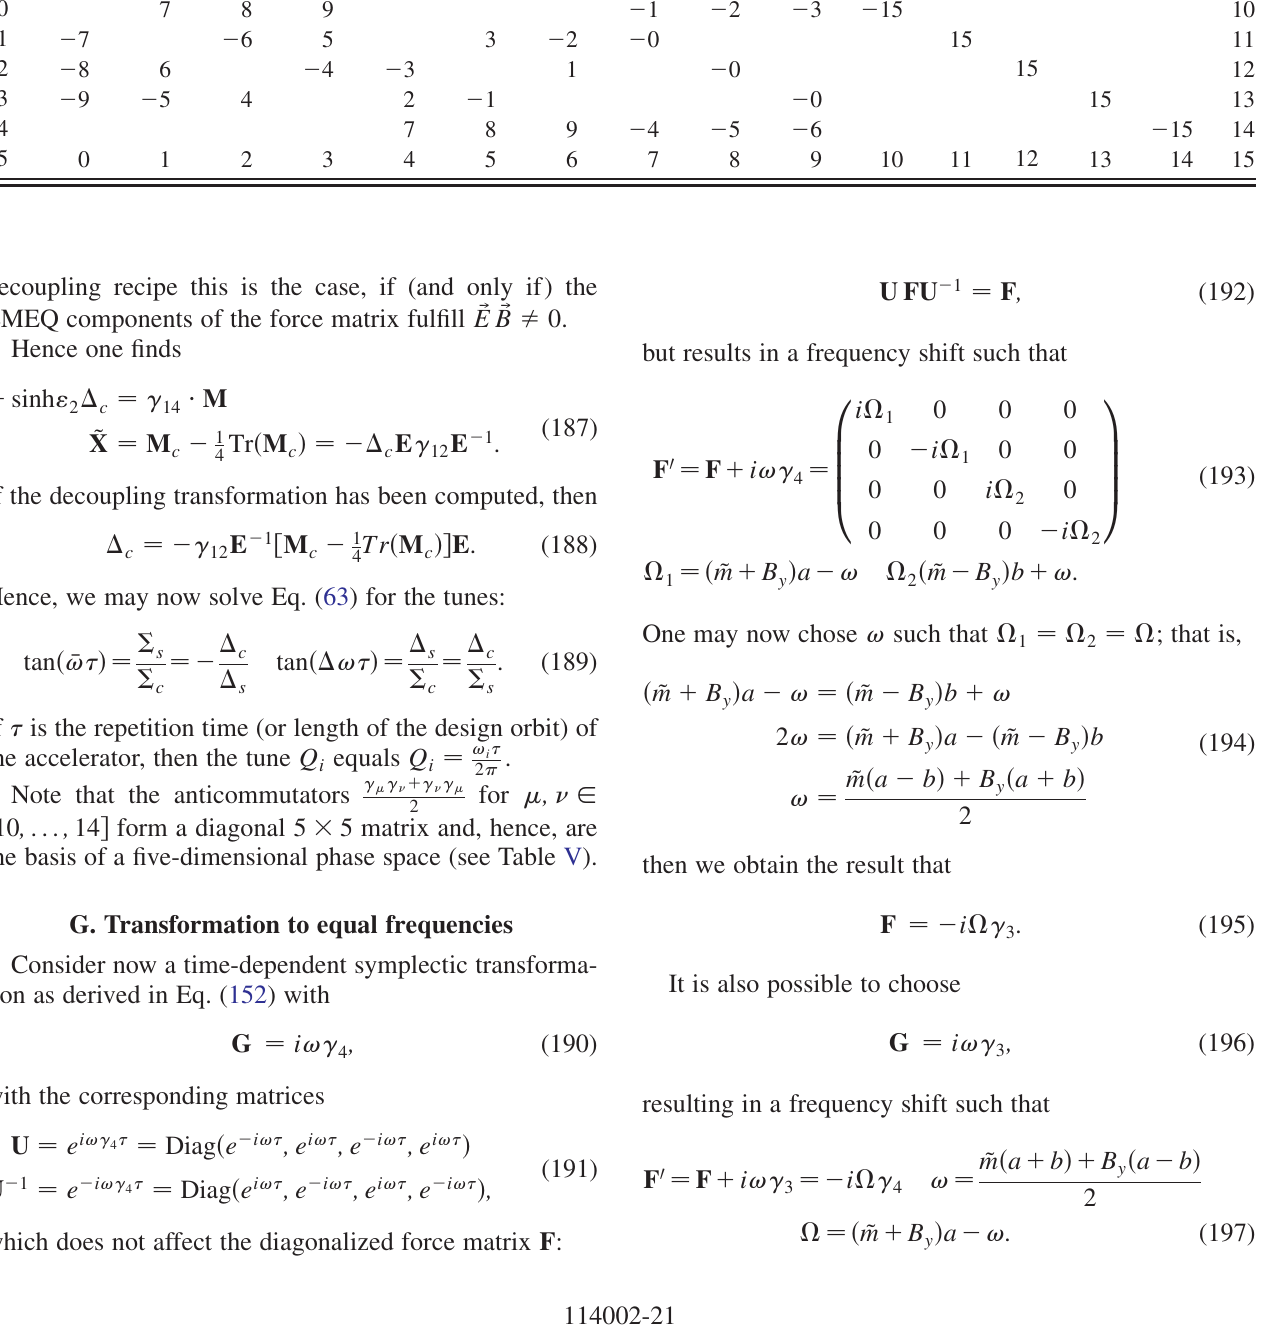
¼ (cid:1) a (cid:1) b þ (cid:1) b (cid:1) a , where a is the index of the row, b the index of the c 2